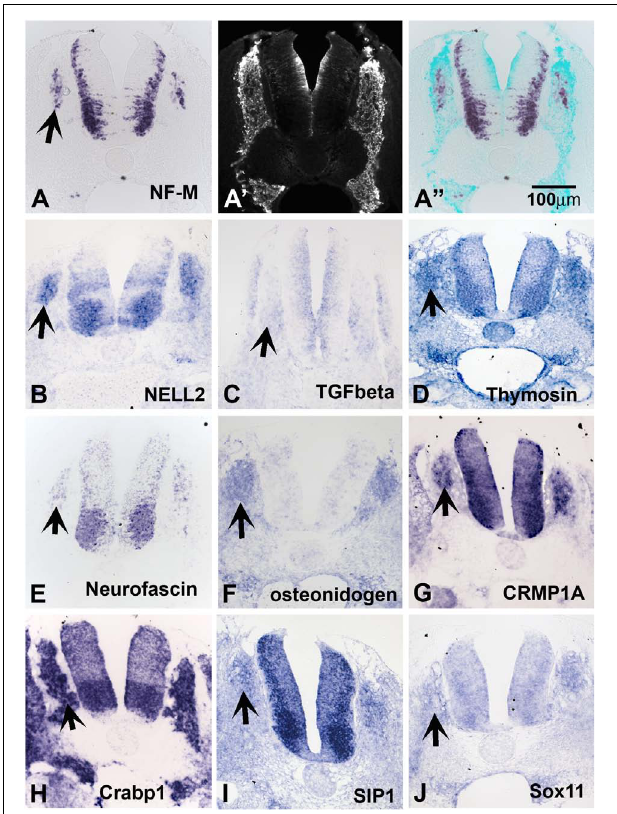
FIGURE 2 | Expression of known genes. Chicken section in situ for set of genes. (A) NF-M. (A’) Shows section immunostained with HNK1. (A”) Shows overlap image of section for HNK1 and NF-M. (B) NELL2. (C) TGFbeta. (D) THYMOSIN. (E) NEUROFASCIN. (F) OSTEONIDOGEN. (G) COLLAPSIN response mediating protein 1A, CRMP1A. (H) cellular retinoic acid binding protein 1, Crabp1. (I) SMAD interacting protein 1, SIP1. (J) SOX11. Arrows point to DRGs.